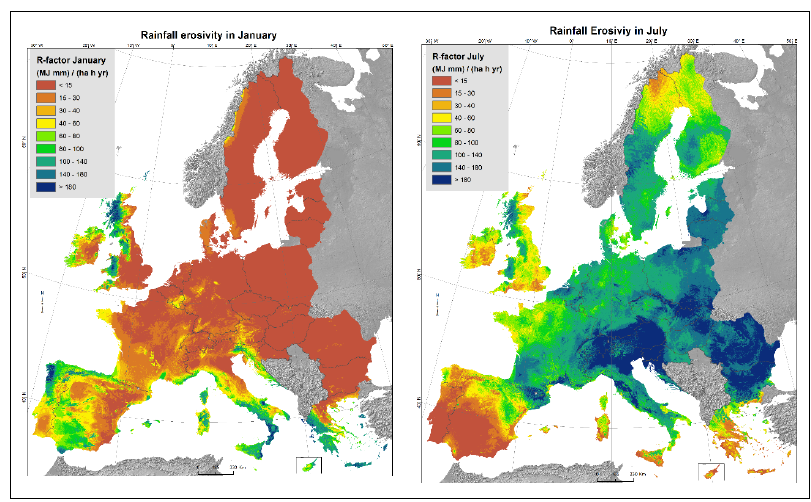
Figure 7 : Monthly erosivity maps for Europe (Left: January; Right: July). Figure 7. Monthly erosivity maps for Europe (Left: January; Right: